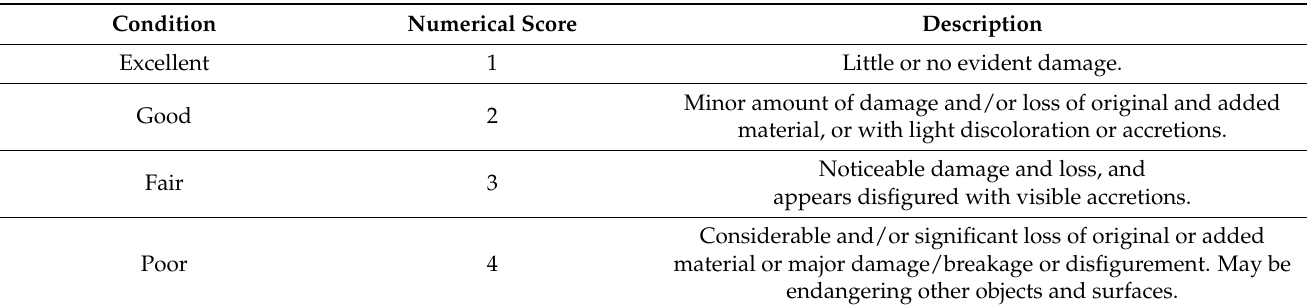
Table 1. Vulnerability scale used to assess condition, drawing on condition definitions described by Keneghan [17] the BMT and the National Trust. Condition Numerical Score Description Excellent 1 Little or no evident